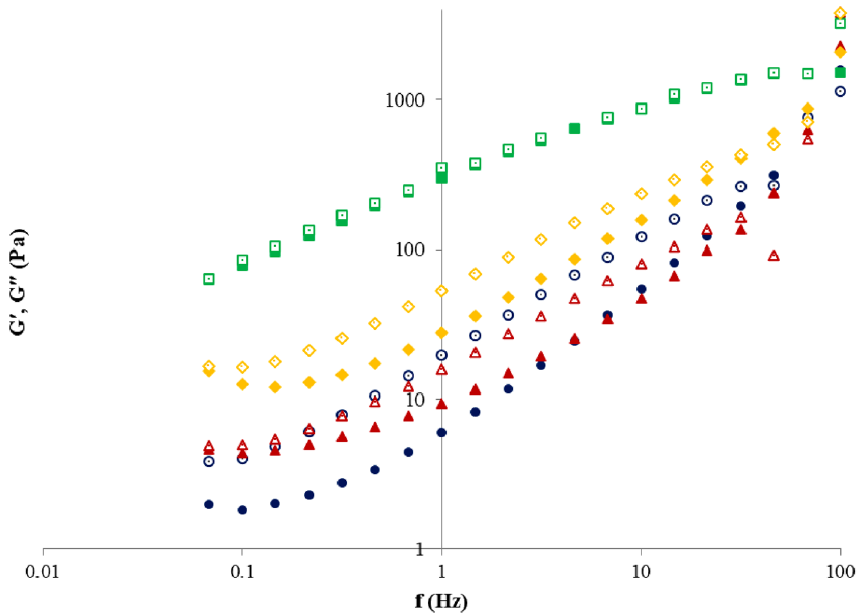
Figure 6. Elastic modulus (fill symbol) and loss modulus (no fill symbol) for different pectin samples: Fetească Neagră pectin ( ▲ , ∆), Rară Neagră pectin ( ♦ , ◊ ), commercial apple pectin ( ● , ○ ) and commercial citrus pectin